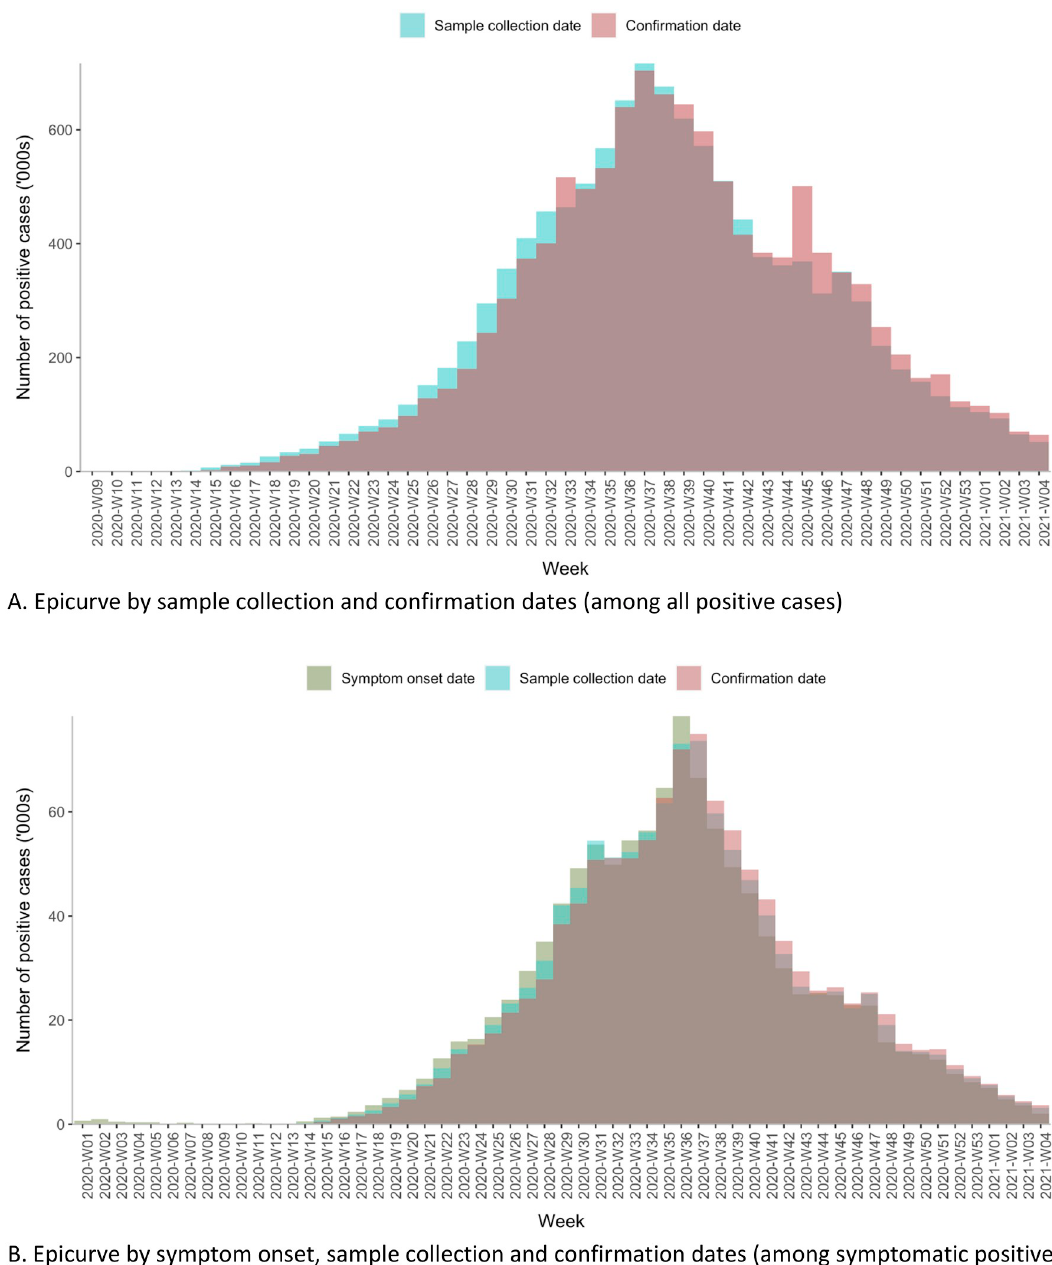
Fig 5. Distribution of laboratory-confirmed COVID-19 cases by dates of symptom onset, sample collection and result confirmation, India (March 2020 to January